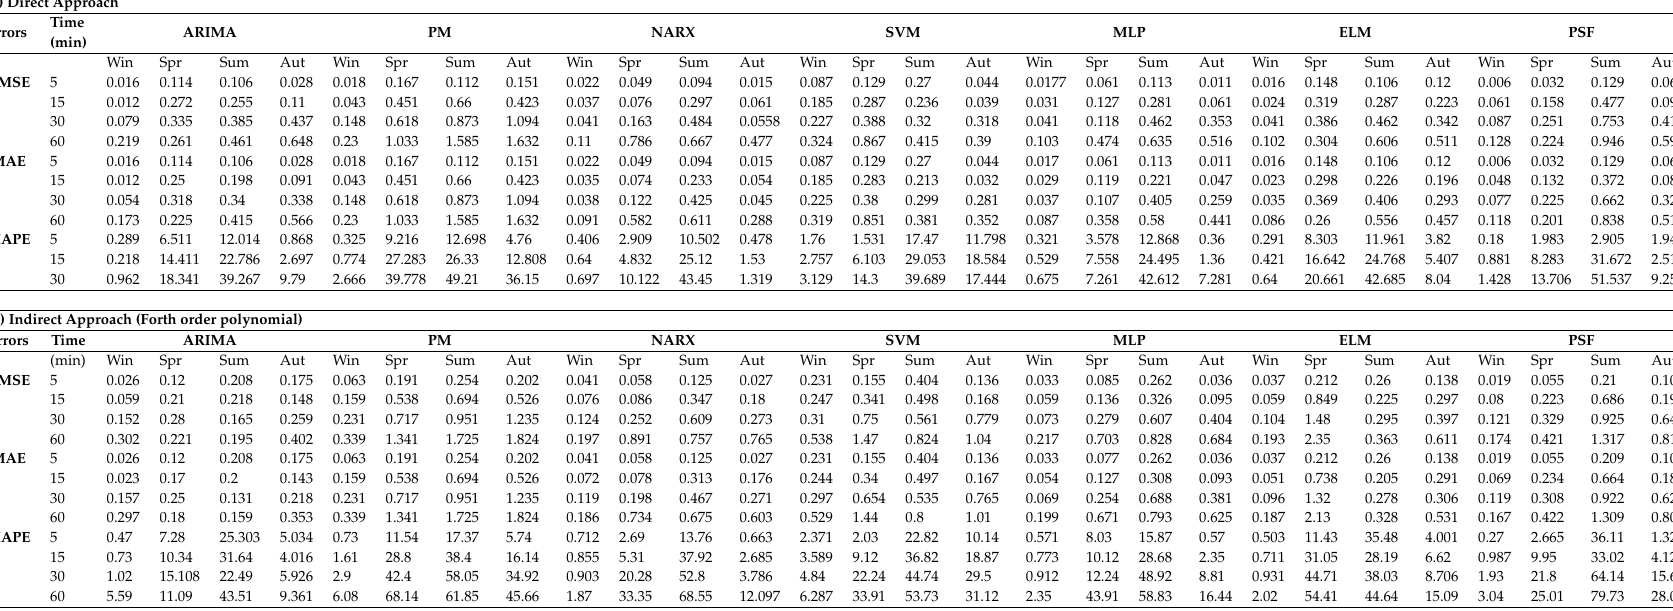
Table A5. Comparison of wind-power prediction results with ( a ) direct prediction approach and indirect prediction approach with curve-fitting techniques: ( b ) fourth-order polynomial